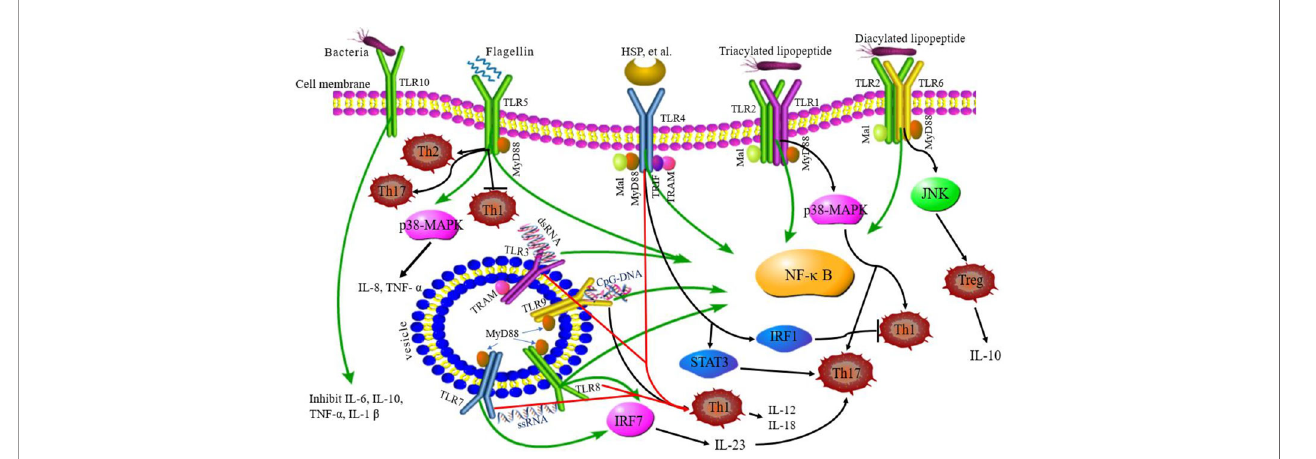
FIGURE 2 | TLRs signaling pathway and related Th responses. TLR1, TLR2, TLR4, TLR5, TLR6, and TLR10 are expressed on the cell surface, while TLR3, TLR7, TLR8, and TLR9 are expressed on intracellular vesicles. TLRs can recognize different ligands and recruit adapter proteins, MyD88, Mal, TRIF, or TRAM, activating the downstream signaling pathway. TLR10 is an orphan receptor and lacks a classical downstream signaling pathway. Some TLRs promote the differentiation of Th cells. TLR2/6 promotes Treg cell differentiation through the JNK pathway. TLR2/1 promotes Th1 and Th17 cell differentiation through p38 MAPK pathway. TLR4 eliminates the Th1 response through IRF1 and promotes Th17 cell differentiation by STAT3 pathway. TLR5 can stimulate the body to induce Th2 response, inhibit Th1 response, and promote DC differentiation into Th17 cells. TLR8 induces the expression of IL-12B and IL-23A, promotes the differentiation of IL-23-dependent Th17 cells. TLR9 promotes the differentiation of Th1 cells. Green lines: TLR signaling pathways; black lines: TLRs related to Th cell differentiation; red lines: co- stimulation of TLRs induced to Th1